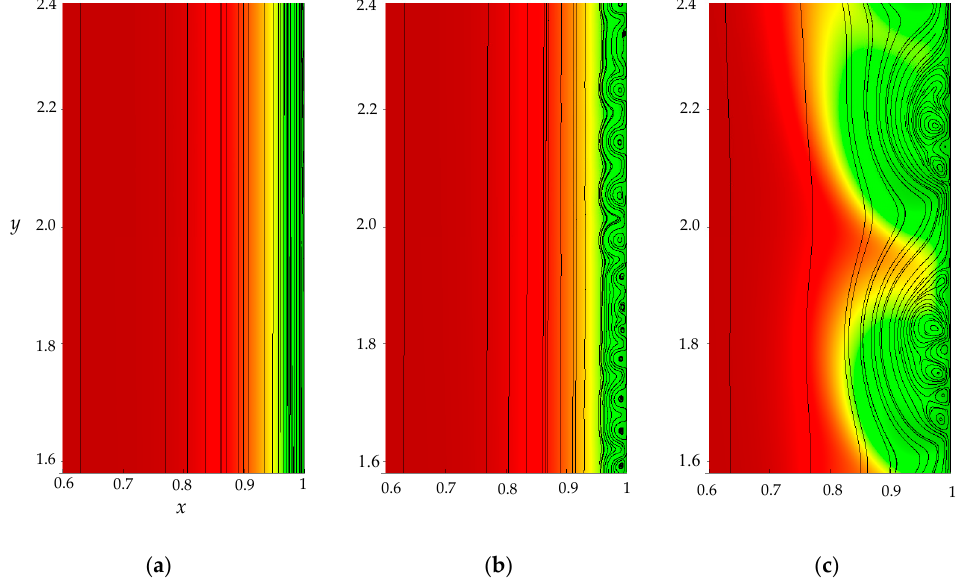
Figure 4. Distribution of cation concentration (the magnitude is shown by different colors), solution streamlines (black lines) in the area at the membrane surface, i av / i lim = 2, τ tan = 3.15 ( a ), τ = 3.95 ( b ), t 1 = 16.72 ( с ).